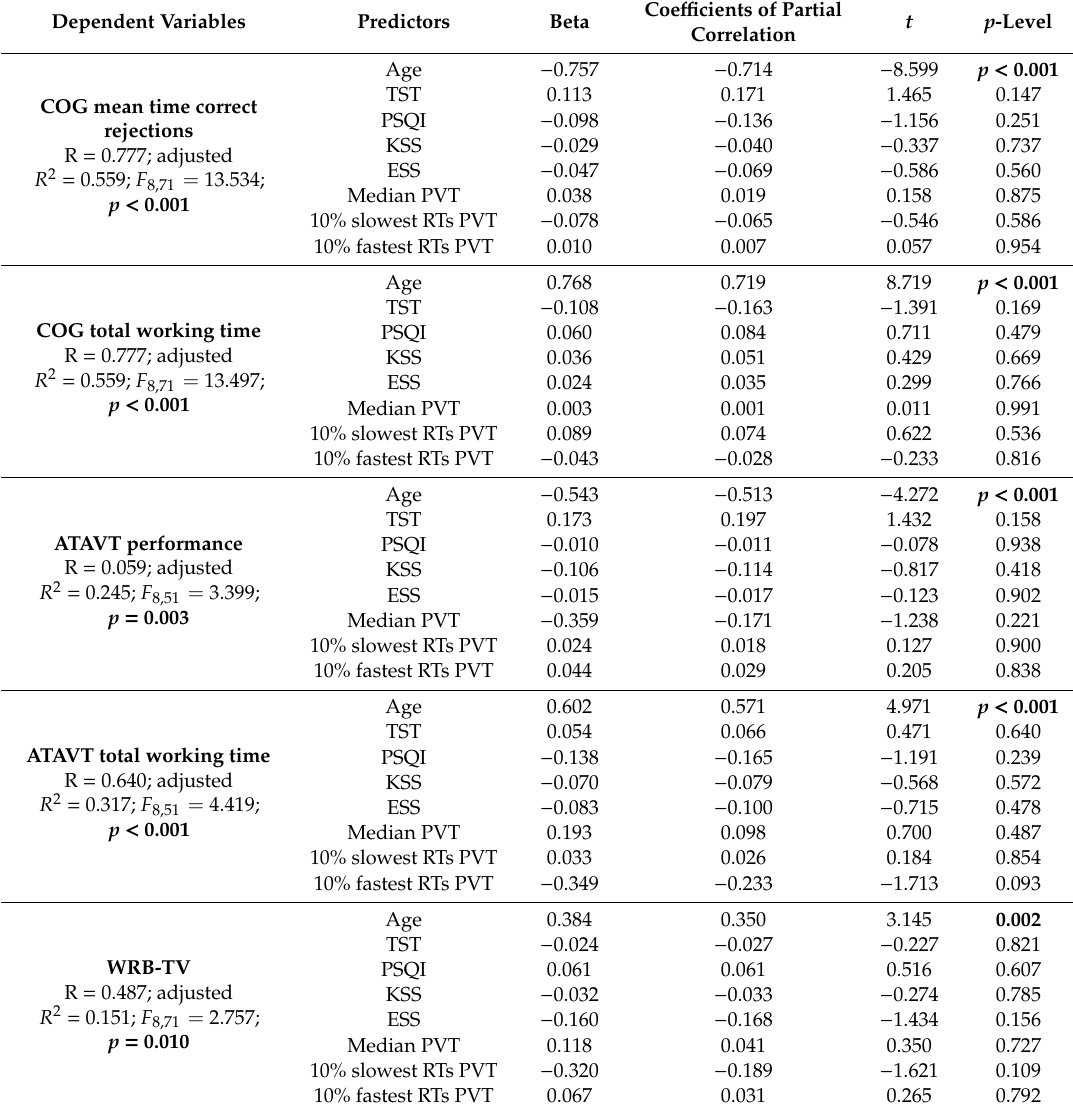
Table 3. Results of multiple regressions ( p < 0.01), considering driving-related cognitive abilities (COG, ATAVT, WRB-TV) as criterion variables and age, TST, PSQI, KSS, ESS, Median PVT, 10% slowest RTs PVT, 10% fastest RTs PVT as